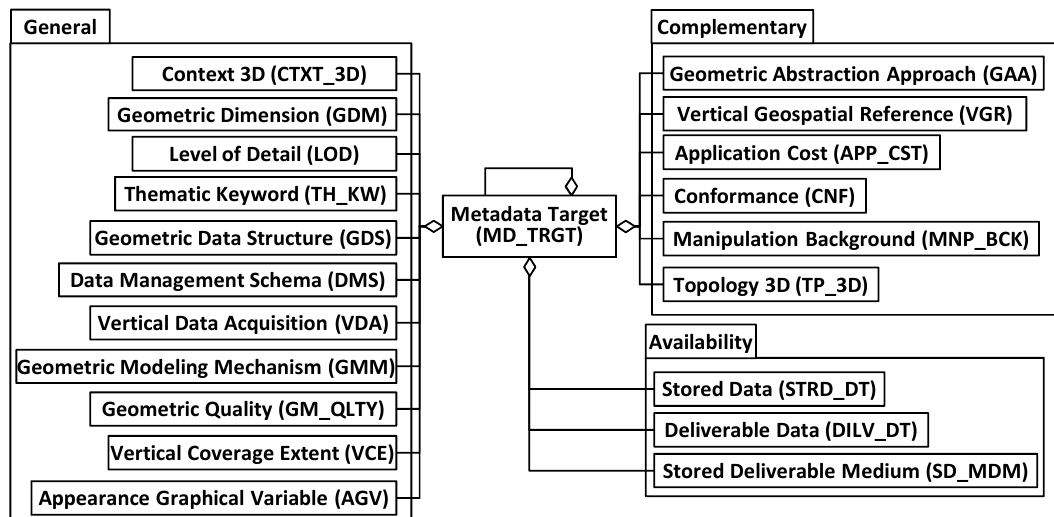
Figure 1. The main structure of the current version of the proposed metadata-set with